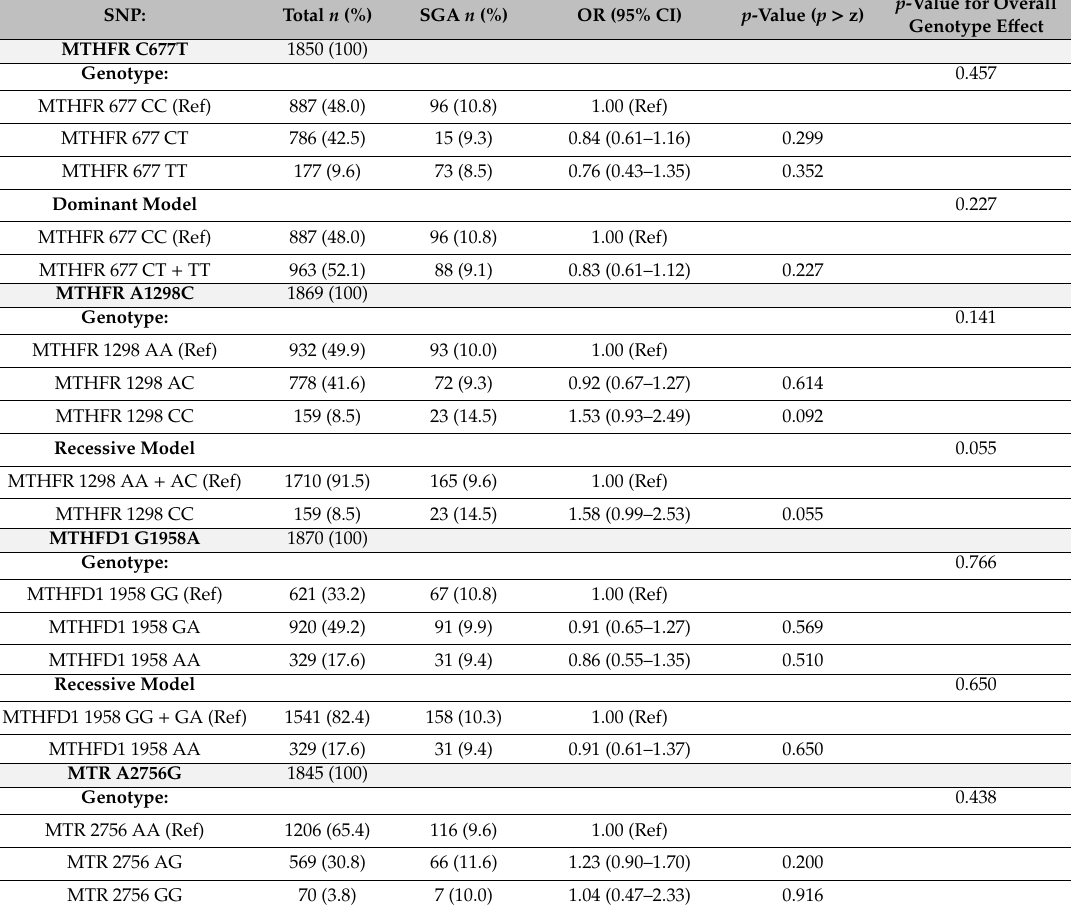
Table 2. Maternal Genotype Frequency and Association between SNPs and SGA Risk in New Zealand SCOPE